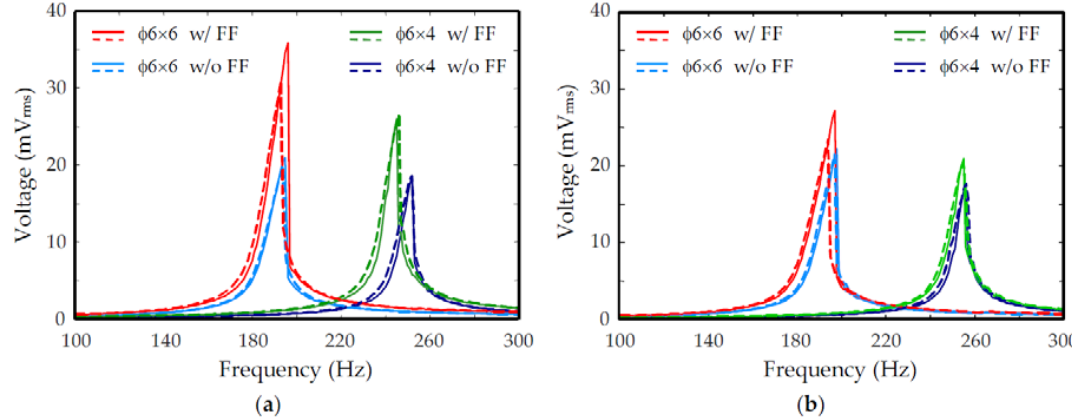
Figure 8. Open-circuited output voltage of proposed harvester with different FF: ( a ) Oil-based FF with µ r = 18.6; and ( b ) water-based FF with µ r = 12.6. Solid and dash lines were obtained with up and down frequency sweeps, respectively. The magnet size is expressed as φ × 2 h (mm × mm).